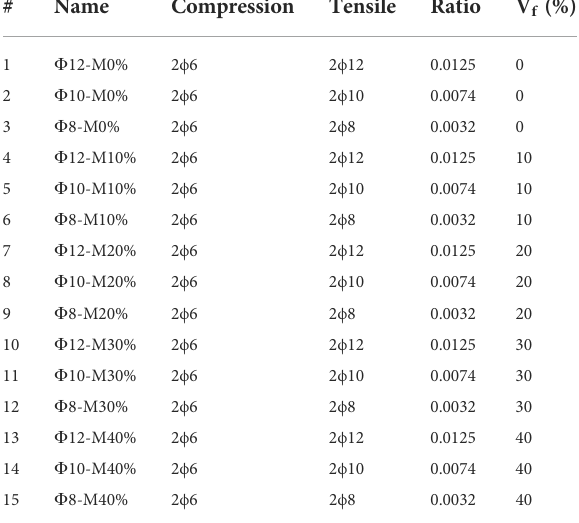
TABLE 1 Properties of